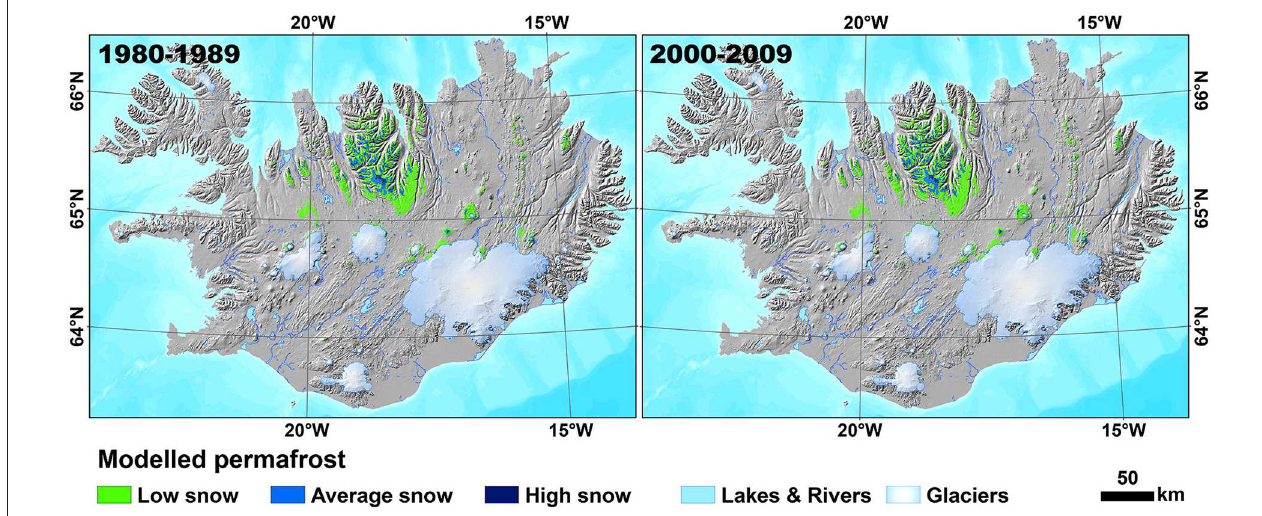
FIGURE 10 | Permafrost extent over the periods 1980–1989 and 2000–2009 based on cells that indicated ground temperature at 10m depth at or below 0 ◦ C in 10 consecutive years for the three snow depth scenarios: “Low snow” represents permafrost reproduced in 50% precipitation scenario, “Average snow” represents permafrost reproduced in 50 and 100% precipitation scenarios, and “High snow” represents permafrost reproduced in all precipitation scenarios. Results for the other periods reveal similar permafrost extent at this depth. Map data from NLSI.